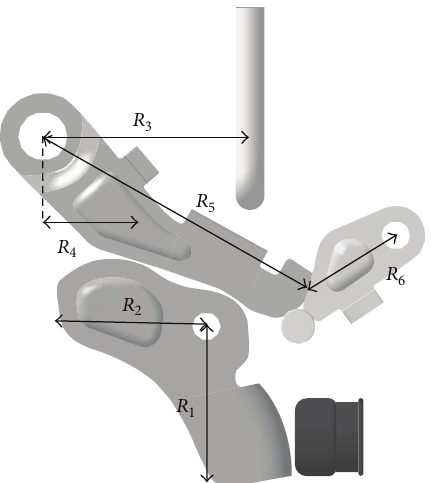
Figure 13: Distances of elements to be adjusted to reduce response